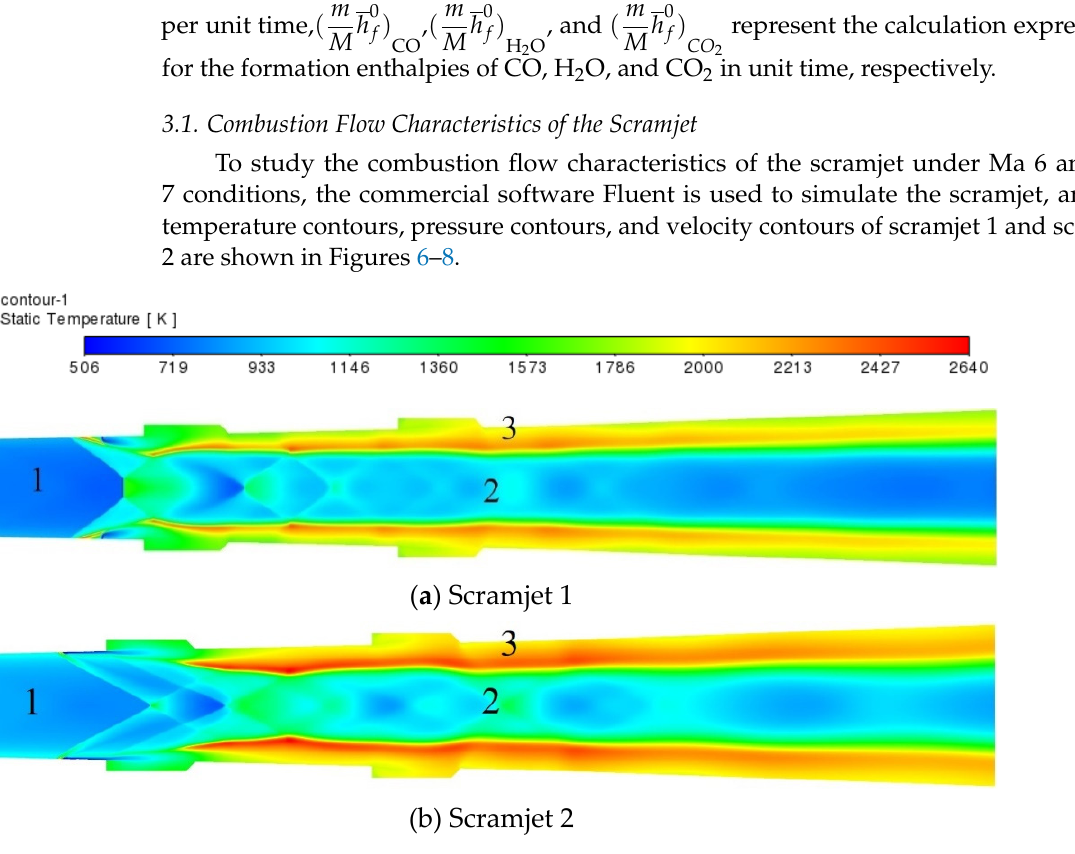
Figure 6. Static temperature contours for scramjet 1 and scramjet 2. 1—Undisturbed zone, 2—Mainstream zone, and 3—Near wall combustion zone.